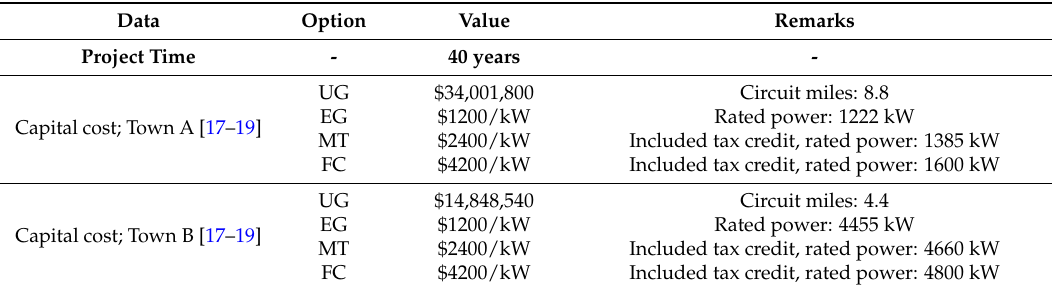
Table 1. General input data. FC: fuel cell and MT: